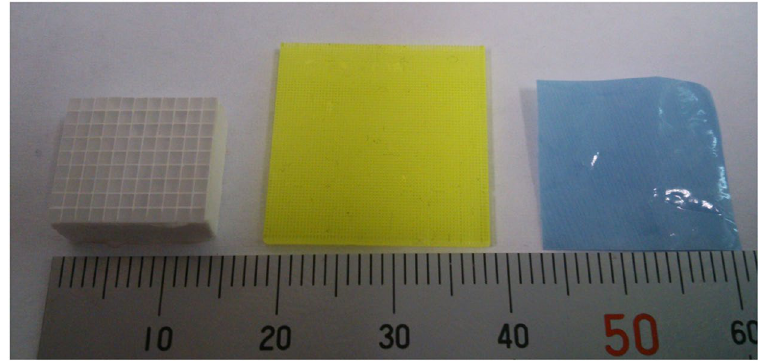
Figure 11. Transparent materials used for the imaging test of system: LGSO scintillator block which has size of 1.1 mm × 1.2 mm pixels with ~50 μ m reflector between pixels (left), GAGG pixel scintillator which has 0.2 mm pixels with 0.1 mm slits between pixels (middle) and color printed plastic sheet which has 50 μ m diameter dots with 30 μ m spaces between dots